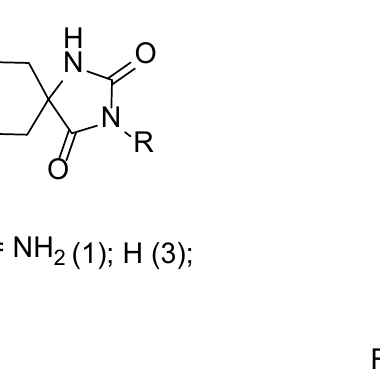
Figure 1. Structural formulas of ligands 1 and 3 and complexes 2 and 4.